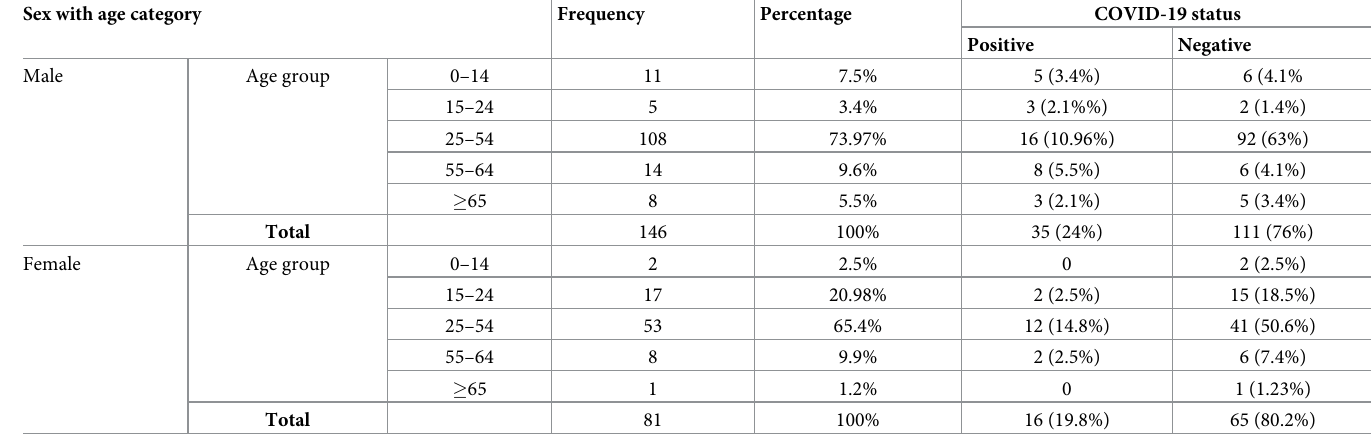
Table 2. SARS-CoV-2 RNA positivity rate difference sex with their respective age groups for comparative evaluation of saliva and NPS for SARS-CoV-2 detection using RT-qPCR among COVID-19 suspected patients at Jigjiga, Eastern Ethiopia. Sex with age category